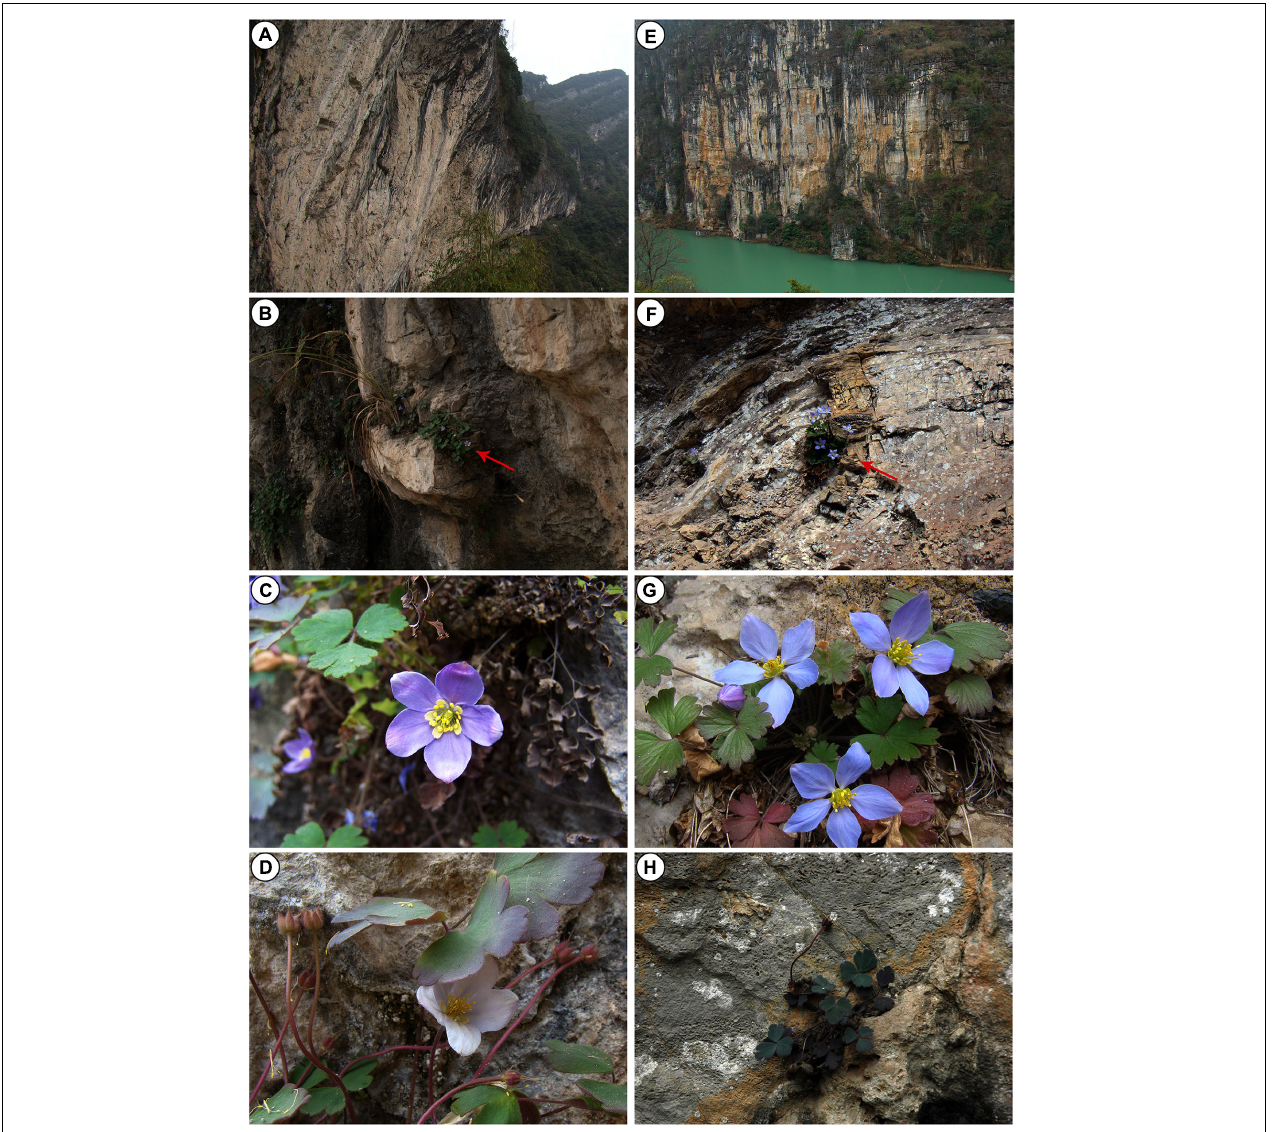
FIGURE 1 | The habitat and morphological characters of Urophysa rockii (A–D) and Urophysa henryi (E–H) . (A,E) Habitat feature; (B,F) growth sites; (C,G) the flowers; (D,H)